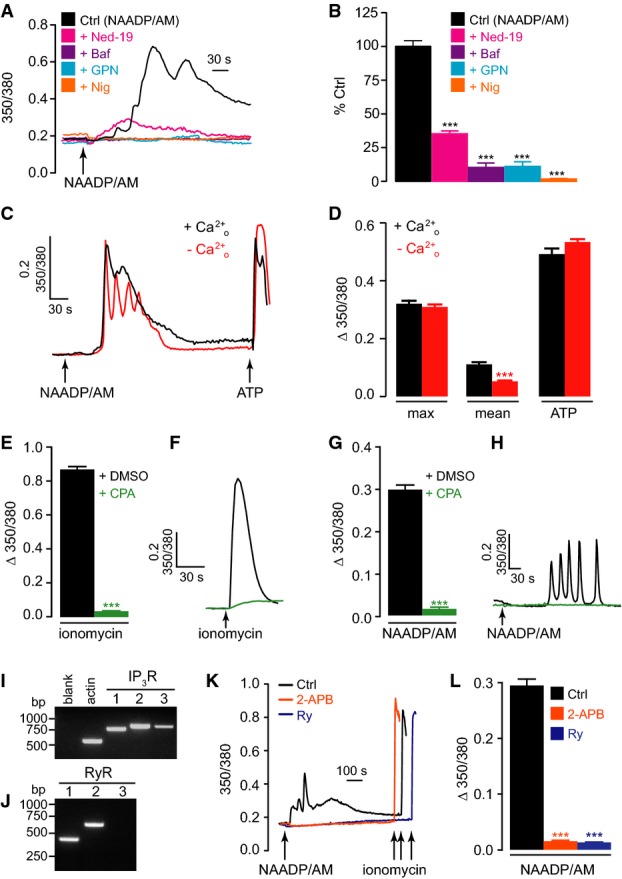
NAADP induces Ca2+ release from acidic Ca2+ stores

A, B Representative single-cell Ca2+ traces showing 350/380 ratios of fura-2 fluorescence (A) and maximum Ca2+ changes (B) upon addition of 10 μM extracellular NAADP/AM in WT MEFs, which were blocked by pre-incubation with 10 μM trans-Ned-19 (Ned-19; 45 min), 1 μM bafilomycin A1 (Baf; 45 min), 5 μM nigericin (Nig; 30 min), or 200 μM GPN (5 min); control (Ctrl) was pre-incubated with DMSO (vehicle); n = 121–272; ***P < 0.001 relative to control using the ANOVA-Tukey test.

C, D Ca2+ signals with 10 μM NAADP/AM in 1.8 mM extracellular Ca2+ (+ Ca2+o) or Ca2+-free medium containing 100 μM EGTA (− Ca2+o) in WT MEFs. (C) Representative single-cell fura-2 Ca2+ traces upon addition of 10 μM NAADP/AM and 100 μM ATP. (D) Maximum Ca2+ changes (max) and mean Ca2+ release over a period of 300 s post-addition of 10 μM NAADP/AM;n = 233–385 cells; ***P < 0.001 relative to + Ca2+o using an unpaired t-test.

E–H Cells treated with 200 μM CPA or 0.1% DMSO in medium + Ca2+o for 50 min. Cells were then briefly washed and maintained in Ca2+-free medium (+100 µM EGTA) in which they were stimulated with 2 μM ionomycin (E, F) or 10 μM NAADP/AM (G, H). Maximum Ca2+ changes (E, G) and representative single-cell fura-2 Ca2+ traces (F, H); n = 49–148 cells; ***P < 0.001 relative to DMSO control, using the unpaired t-test.

I, J MEFs express all three IP3 receptor subtypes (IP3R 1–3) and ryanodine receptor (RyR) types 1 and 2, detected by RT–PCR analysis. Blank refers to no RNA. Positive control for expression for RyR type 3 is shown in Supplementary Fig S1.

K, L Cells treated with 2 μM 2-APB, 20 μM ryanodine, or 0.1% DMSO prior to application of 10 μM NAADP/AM. Representative single-cell fura-2 Ca2+ traces (K) and maximum Ca2+ changes (L); n = 142–374; ***P < 0.001 relative to control using the unpaired t-test.

Data information: Error bars represent SEM. See also Supplementary Fig S1. Source data are available online for this figure.